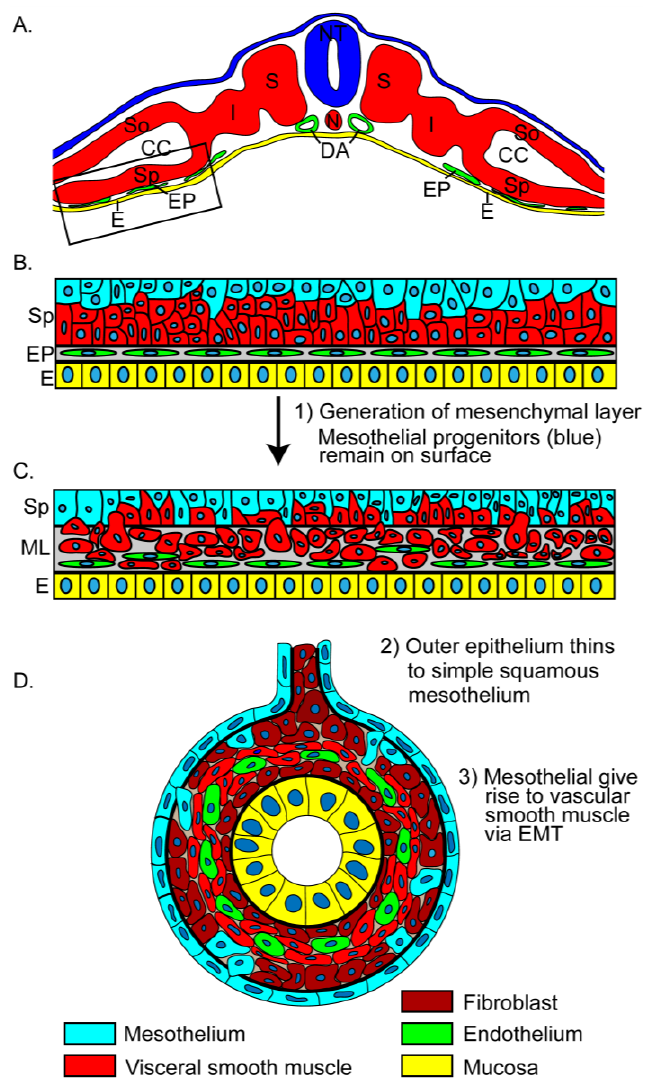
Figure 6. Intestinal mesothelial development. ( a ) Schematic depicting an early embryo yet to undergo lateral folding. ( b ) The splanchnopleure of the intestinal anlage (boxed area in A) is composed of splanchnic mesoderm (Sp) and endoderm (E) with an intervening endothelial plexus (EP). The mesothelial progenitors (blue) are distributed primarily near the surface of the stratified splanchnic mesoderm while fibroblast and visceral smooth muscle progenitors are deep (red). ( c ) Cells of the splanchnic mesoderm undergo EMT and invade the mesenchymal space joining the endothelial plexus to form the mesenchymal layer (ML). The mesodermal basement membrane breaks down through this process (broken black line). ( d ) A simple squamous mesothelium (blue) is present on the surface by day 6 of chick development and E11.5 of mouse development. Mesothelial cells undergo EMT to give rise to vascular smooth muscle. CC, coelomic cavity; DA, dorsal aorta; E, endoderm; I, intermediate mesoderm; N, notochord; NT, neural tube; S,